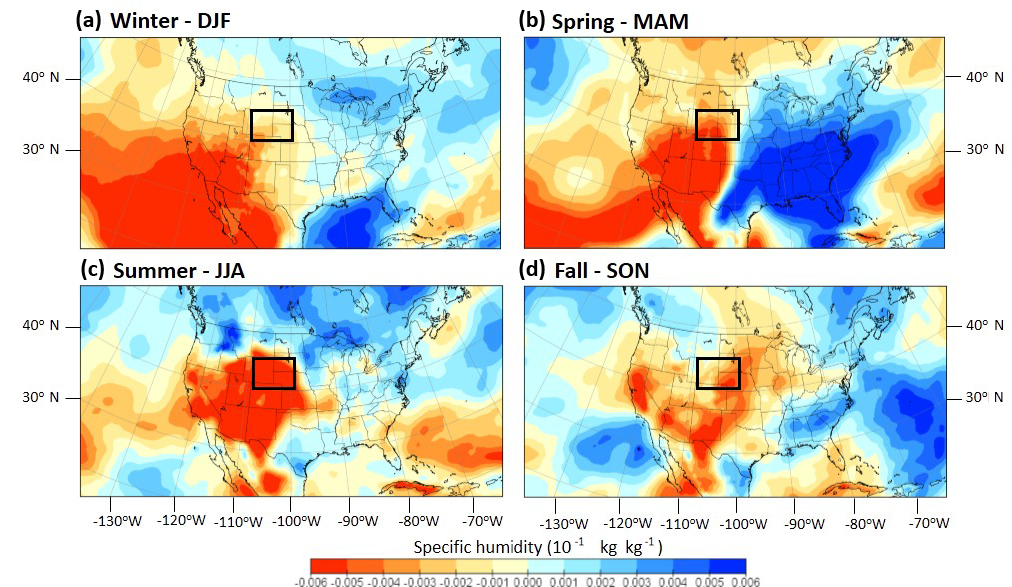
Figure 10. Composite-anomaly maps for 850mbar specific humidity during (a) winter (DJF); (b) spring (MAM); (c) summer (JJA); and (d) fall (SON). Positive values (cool colours) for 850mbar specific humidity indicate wetter-than-normal conditions in the atmosphere. Negative values (warm colours) indicate drier-than-normal conditions. The black box denotes the study